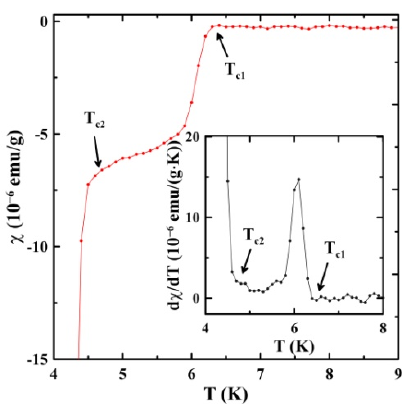
Figure 3. Temperature dependence of the ZFC susceptibility at 10 Oe near the superconducting transitions. The inset shows the first derivative.